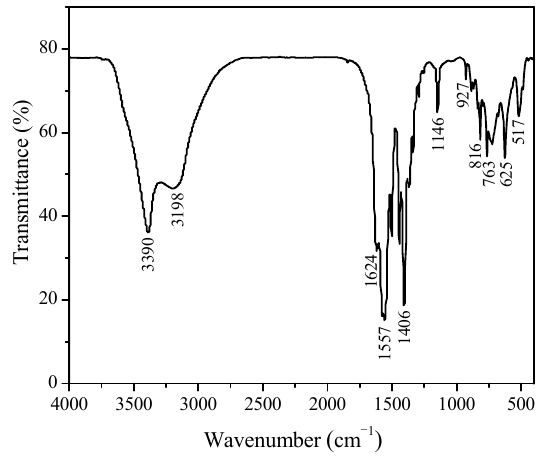
Figure 4. FTIR spectrum of [Zn 2 (btca)(H 2 O) 4 ].